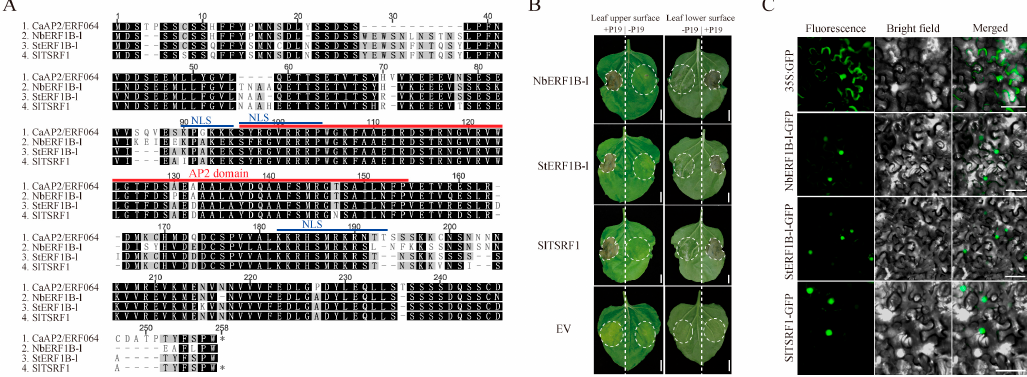
Figure 3. Induction of cell death by CaAP2/ERF064 homologues in N. benthamiana . ( A ) Sequence alignment of CaAP2/ERF064 and its homology proteins. ( B ) Transient over-expression of StERF1B-l, NbERF1B-l, and SlTSRF1 in N. benthamiana . EV was short for empty vector. Scale bar represents 1 cm. The photograph was taken at seven days post-infiltration. ( C ) Localization of StERF1B-l, NbERF1B-l, SlTSRF1 proteins in N. benthamiana epidermal cells. The scale bar represents 50 µ